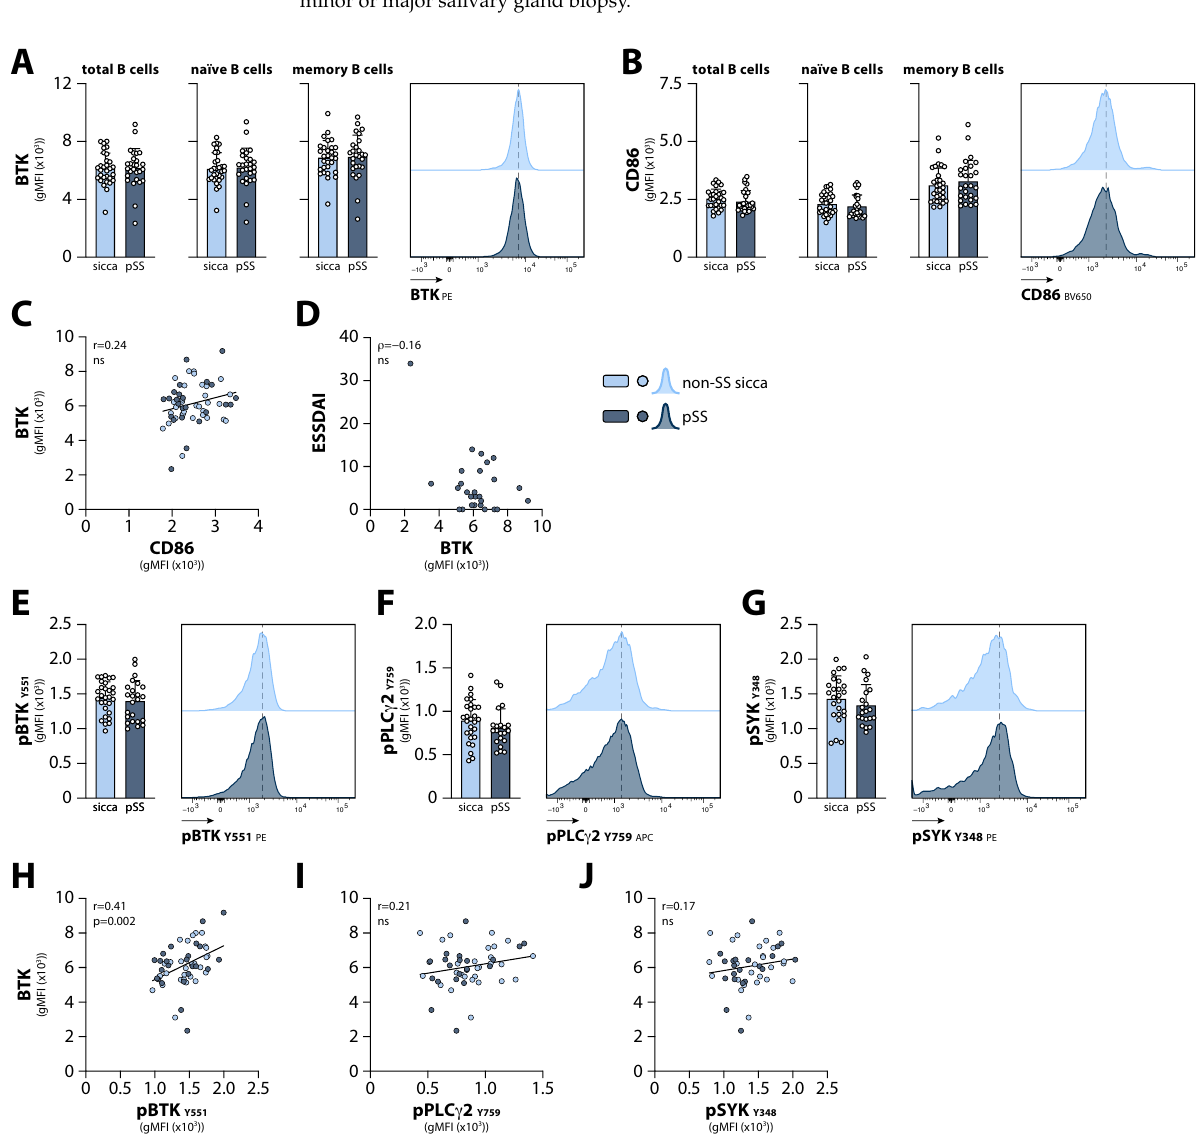
Figure 1. B cell receptor signaling activity in circulating B cells from non-SS sicca and pSS patients. Expression of ( A ) intracellular BTK protein and ( B ) surface CD86 in total, naïve, and memory B